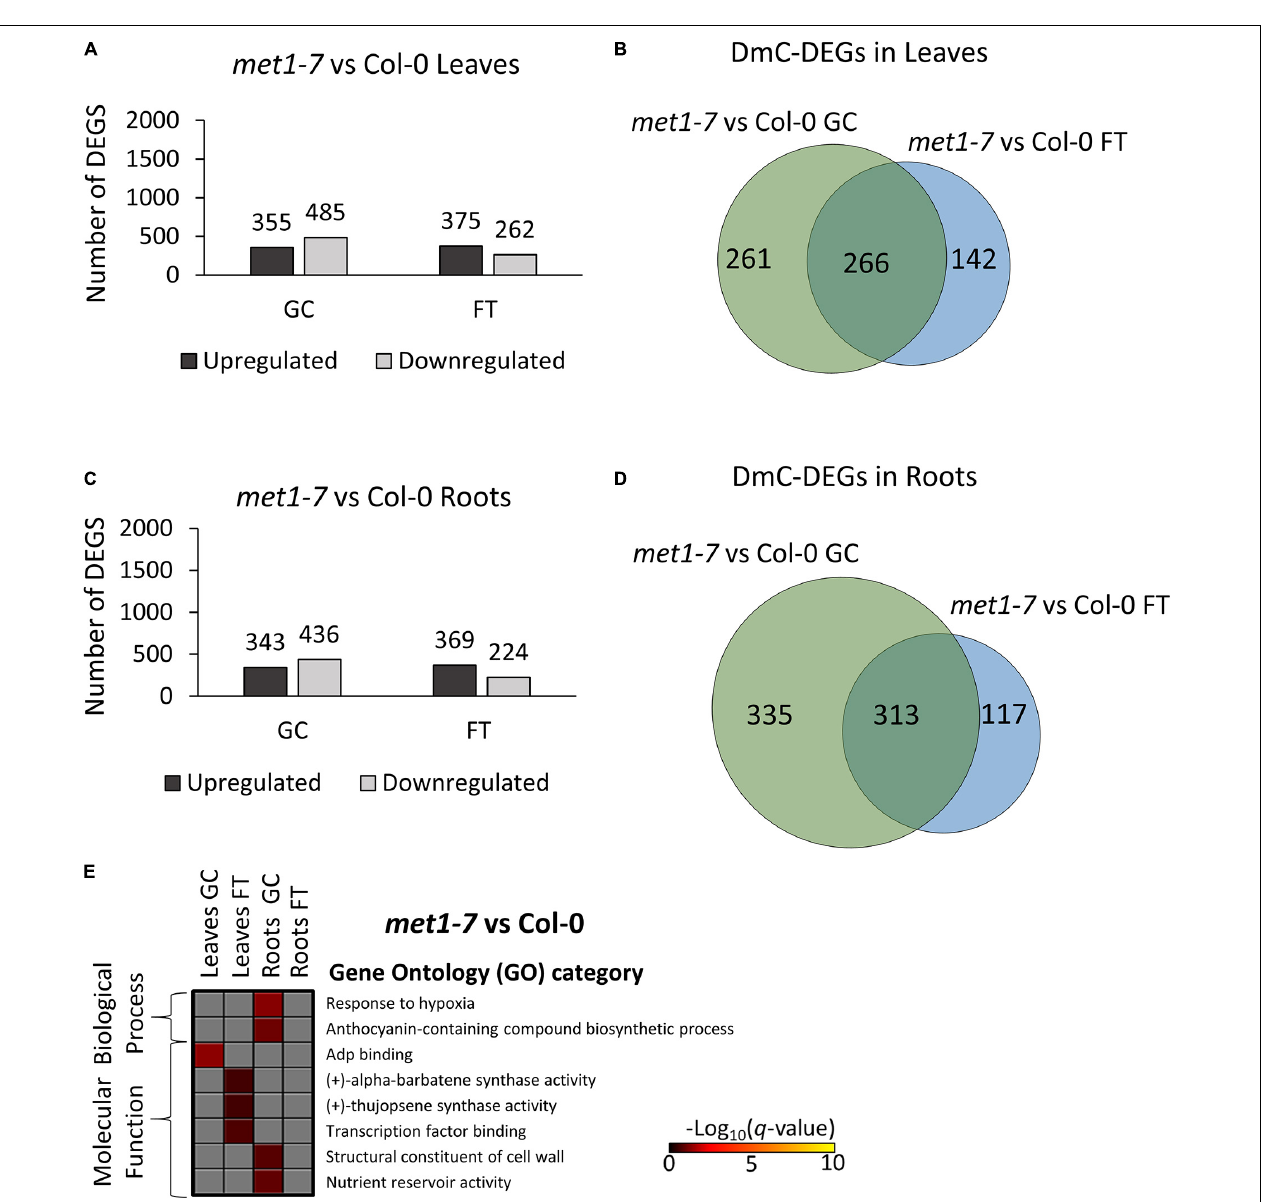
FIGURE 9 | Pairwise comparison of met1-7 mutant vs wild-type Col-0 DEGs-DmCs on the ground and in spaceflight. (A) Bar graph showing the number of DEGs between met1-7 and Col-0 leaves on the ground (GC) and in spaceflight (FT). Black bars indicate the number of up-regulated genes whereas gray bars indicate the number of down-regulated genes. (B) Venn diagrams shows the number of DEG-DmCs that overlap between met1-7 and Col-0 leaves on the ground and in spaceflight. (C) Bar graph showing the number of DEGs between met1-7 and Col-0 roots in GC and in FT. Black bars indicate the number of up-regulated genes whereas gray bars indicate the number of down-regulated genes. (D) Venn diagrams shows the number of DEG-DmCs that overlap between met1-7 and Col-0 roots in GC and in FT. (E) Gene ontology (GO) enrichment analyses of DmC-DEG genes in met1-7 vs Col-0 comparison of both leaves and roots in each environment (GC and FT). The heatmap shows the GO terms that were enriched within each environment and tissue combination between met1-7 and Col-0. The scale bar represents the negative Log 10 of the q -values (corrected p -values) from the “test of significance of enrichment” within each list of DmC-DEGs. The q -value cutoff was set at 0.05. Higher values in the scaling indicate higher significance of the